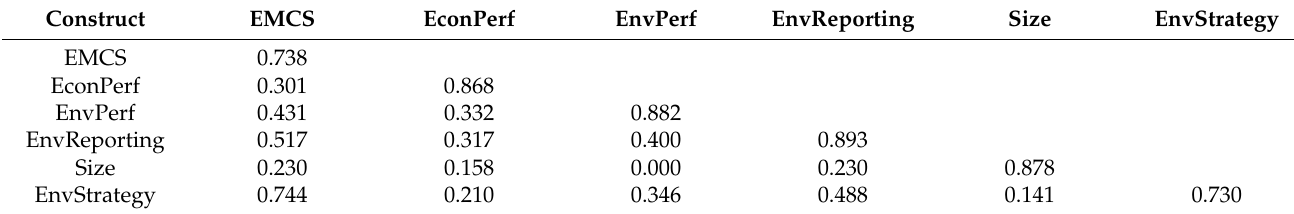
Table 3. Discriminant validity (Fornell–Larcker Criterion).